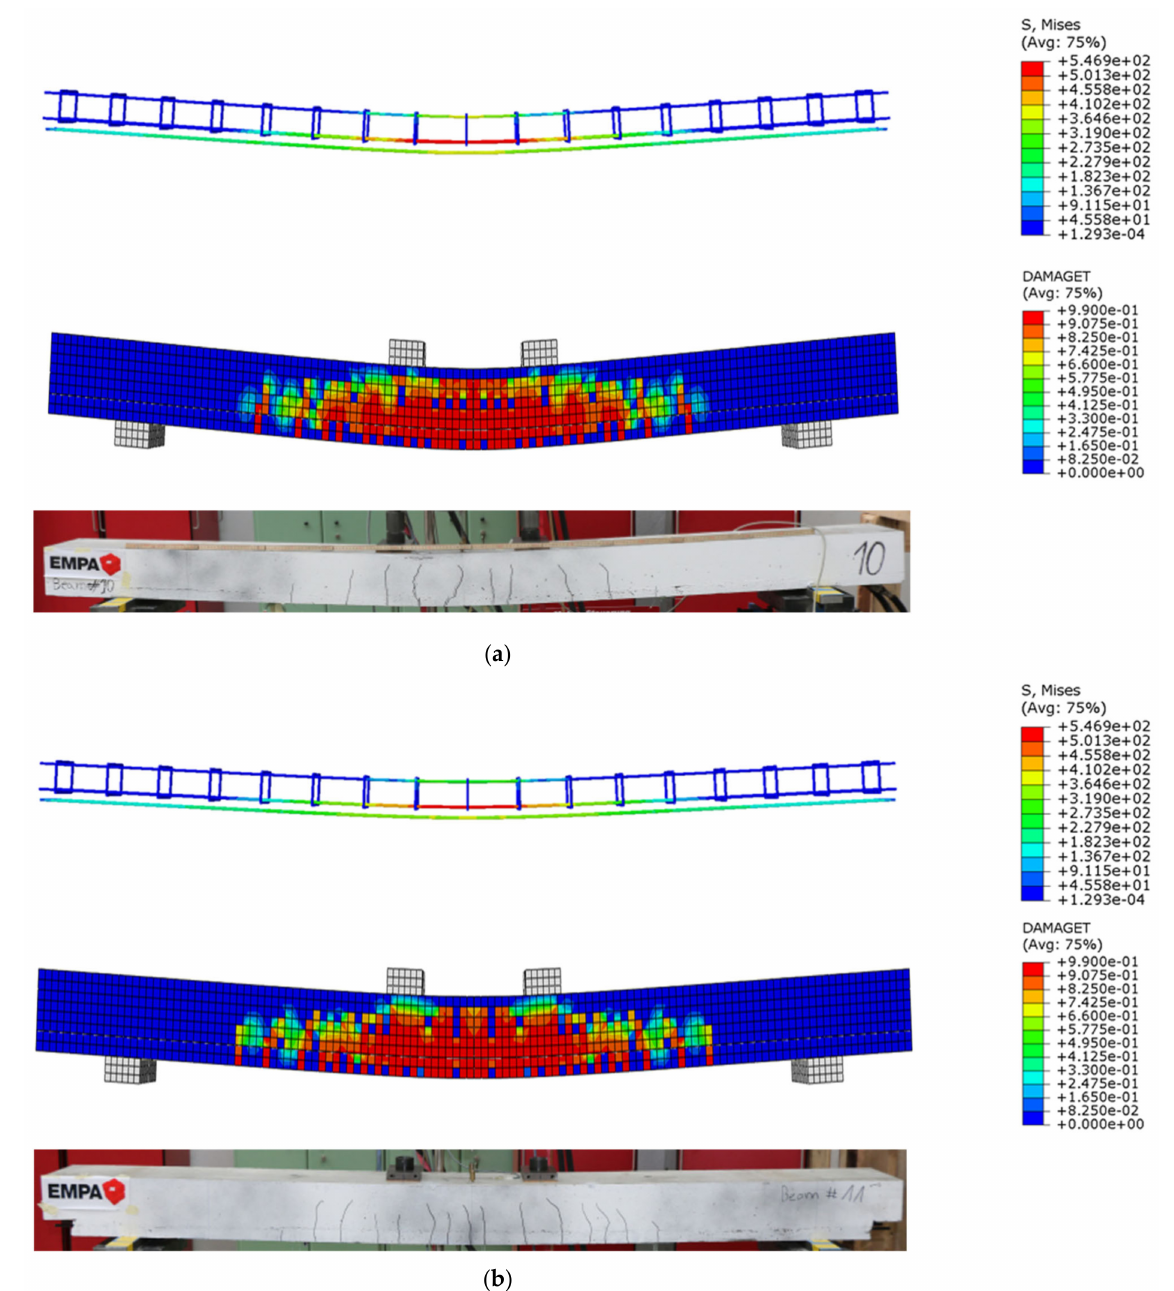
Figure 12. FE model and experimental crack patterns: ( a ) beam 10, ( b ) beam